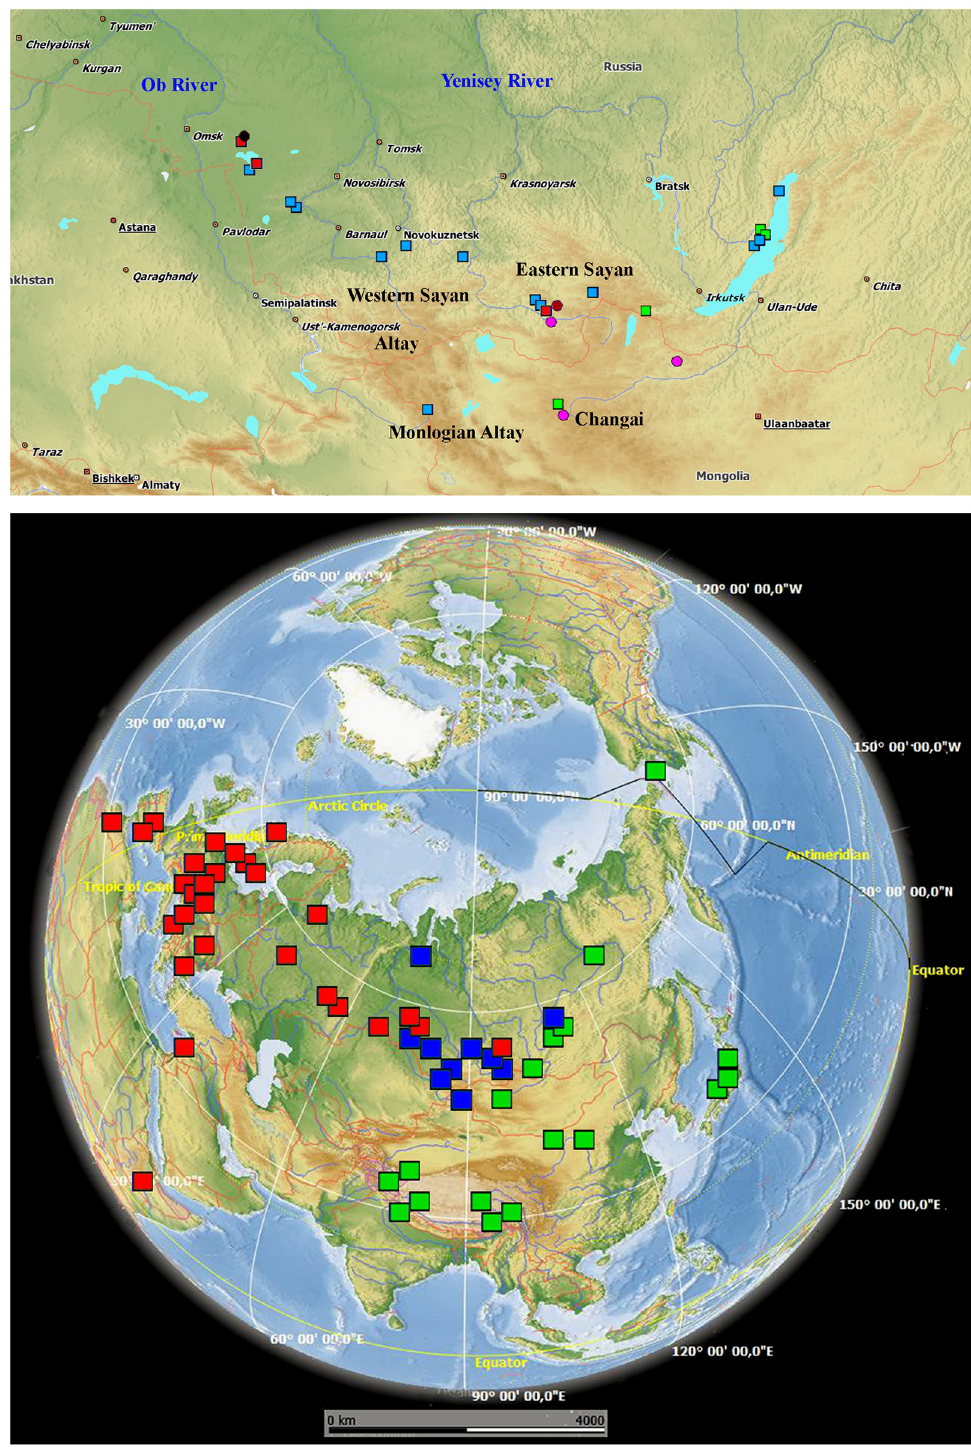
Fig 1. Distribution of the taxa and phylogroups of Daphnia longispina complex in Eurasia. Upper panel—a map of Southern Siberia and Mongolia; lower panel—global map. Shapes of different colors correspond to different species, namely: red squares, D . longispina clade B; blue squares, D . longispina clade A; green squares, D . dentifera ; black circle, D . cf. longispina ; pink circles, D . turbinata ; brown circle, D . umbra . The base map for lower panel was obtained from the open domain plain map available at https://marble.kde.org/.